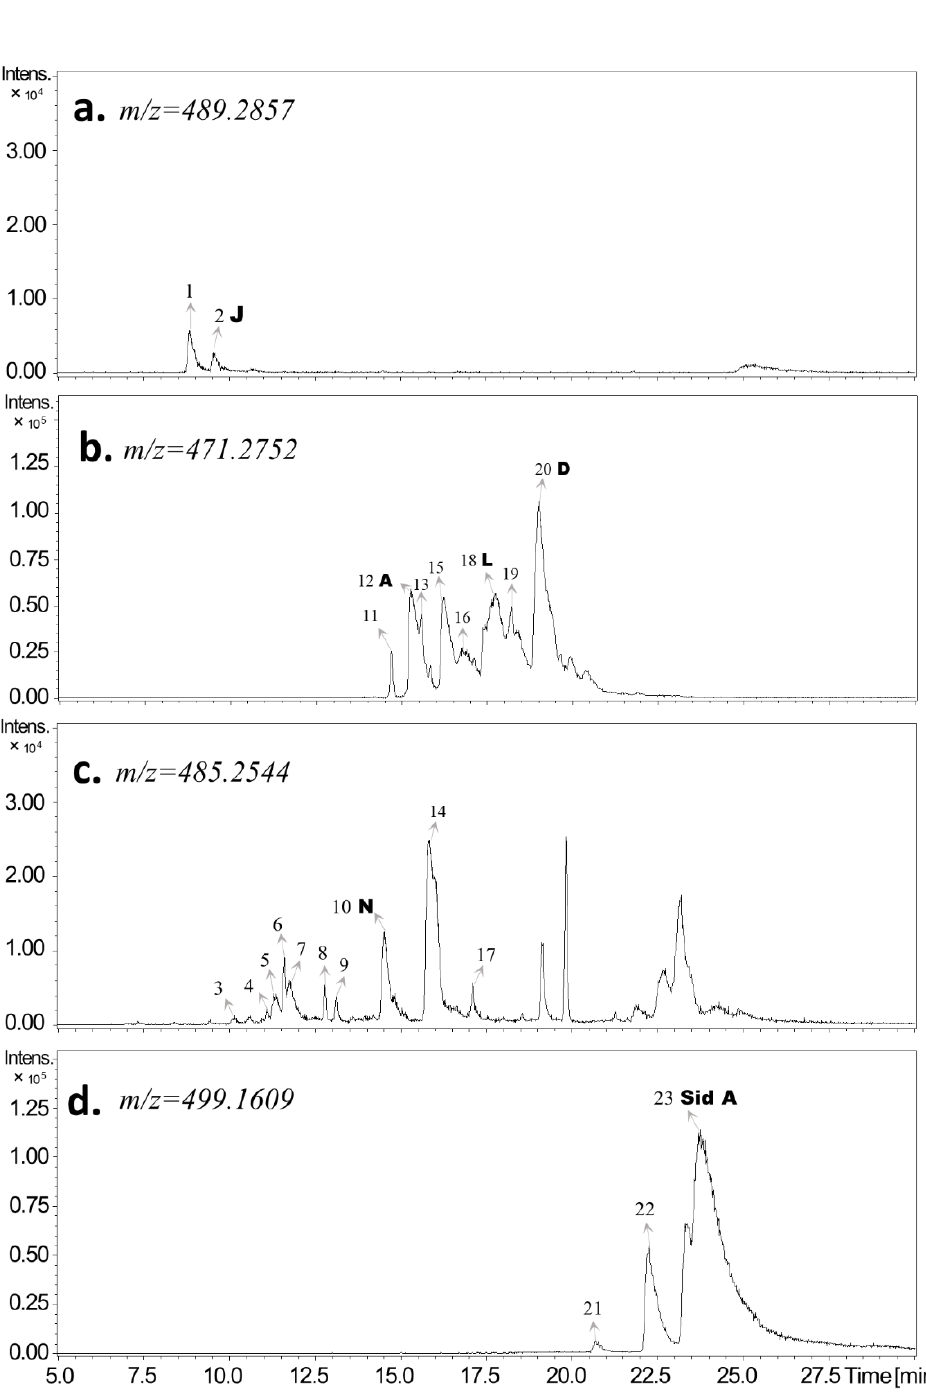
Figure 2. Representative UHPLC-DAD-qToF-MS/MS extracted ion chromatograms showing FPCs detected in E. globulus leaves. The FPCs detected in E. globulus leaves are divided into four groups according to m / z values [M − H] − of 489.2857 ( a ), 471.2752 ( b ), 485.2544 ( c ), and 499.1609 ( d ). Based on co-elution with authentic standards, known FPCs are indicated by arrows with letters. See FPC identification in Material and Methods and the peak details in Table 1. Abbreviations: A, macrocarpal A; D, macrocarpal D; J, macrocarpal J; L, macrocarpal L; N, macrocarpal N; and Sid A, sideroxylonal A.